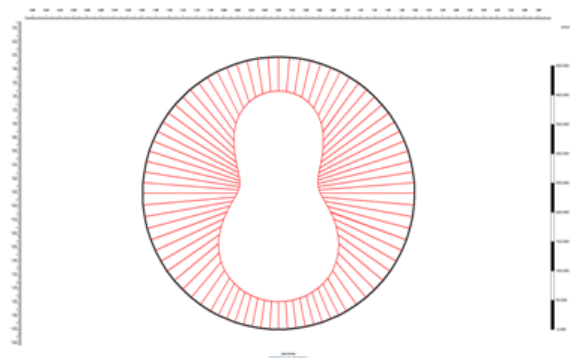
Figure 10. The diagram of axial force for fibre rein- forced sand backfill ( N max = 164 . 28